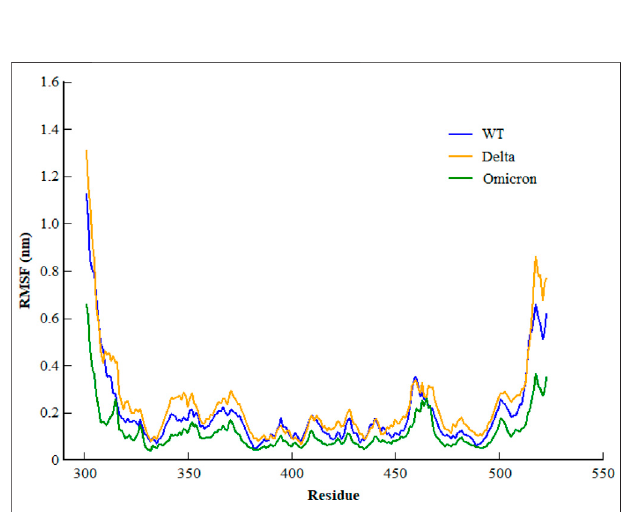
FIGURE 3 | Root mean square fl uctuation of backbone carbon atom of SARS-CoV-2 WT, Delta, and Omicron variants during the course of 100ns of simulation.